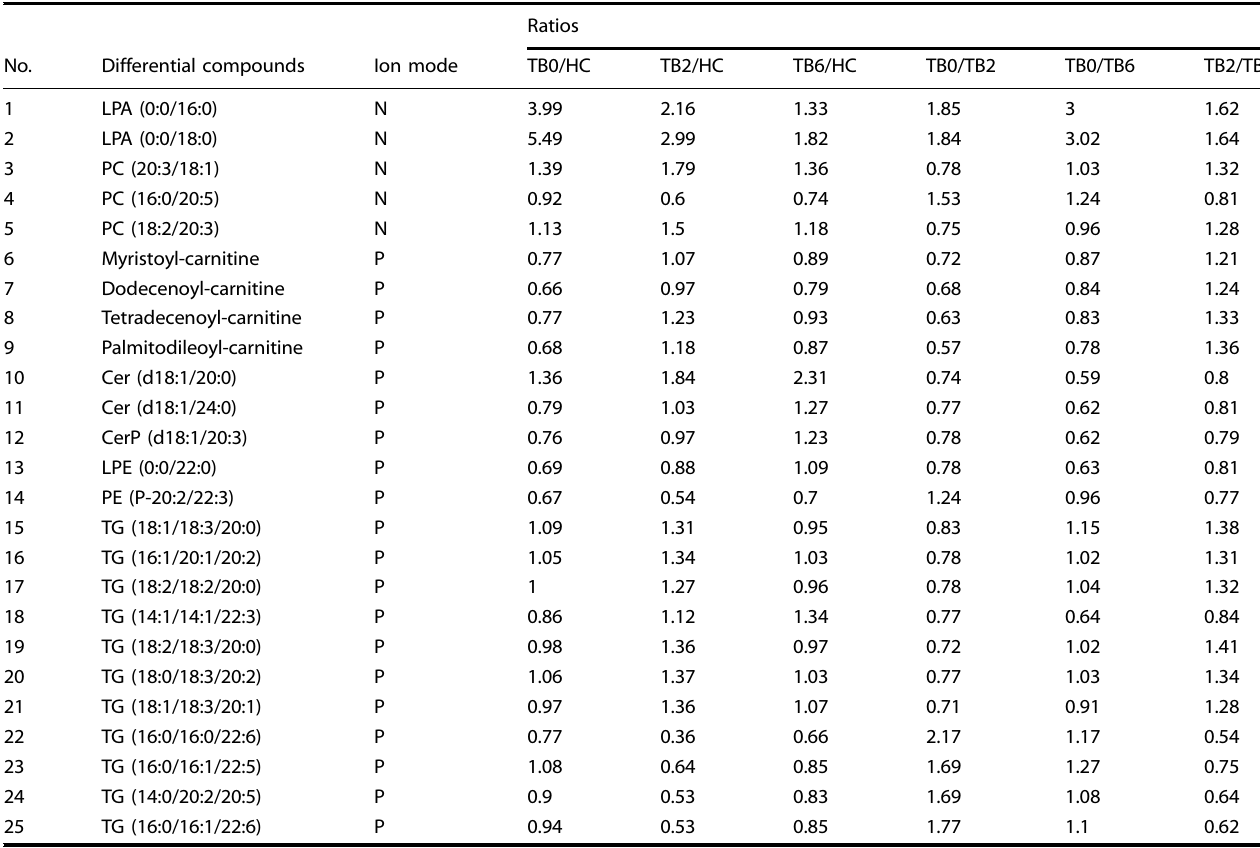
Table 3. 25 Differential lipid metabolites among TB0, TB2, TB6, and